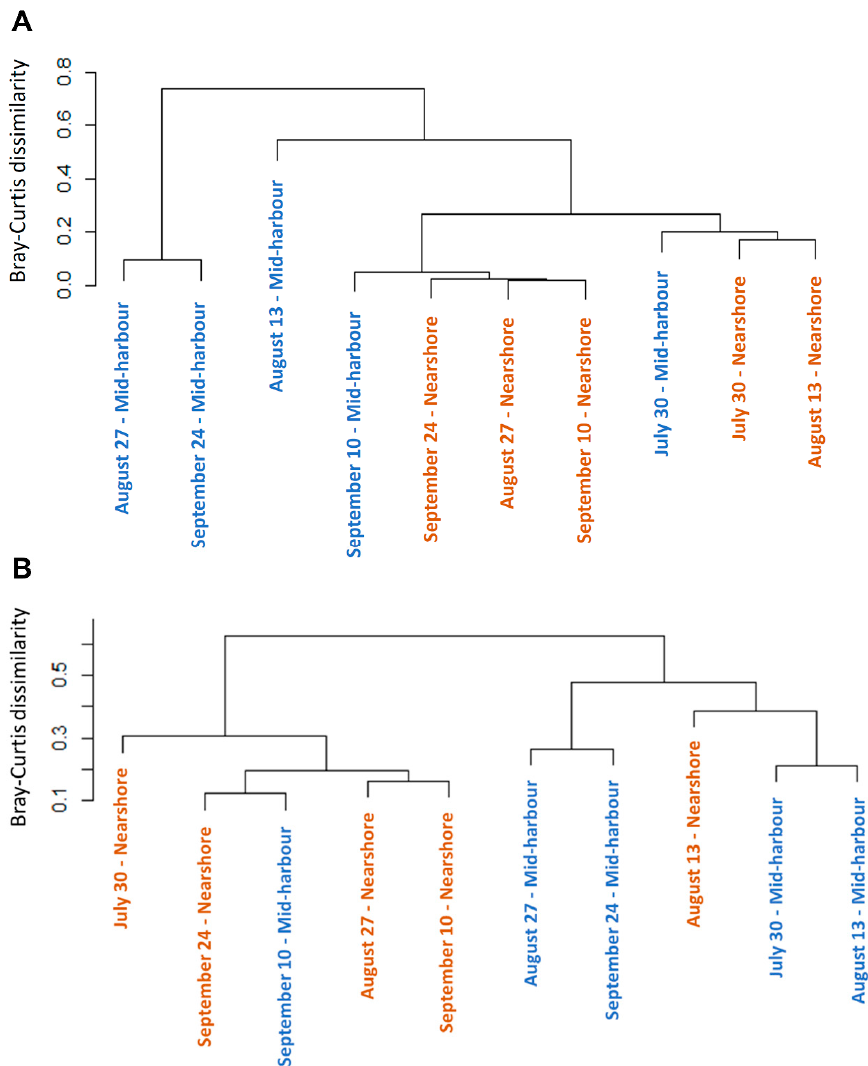
Figure 3. Dendrogram of cluster analysis based on Bray–Curtis dissimilarity index of the ( A ) overall virus community and ( B ) Mimiviridae community. Nearshore samples are coloured orange and mid-harbour samples are coloured blue.